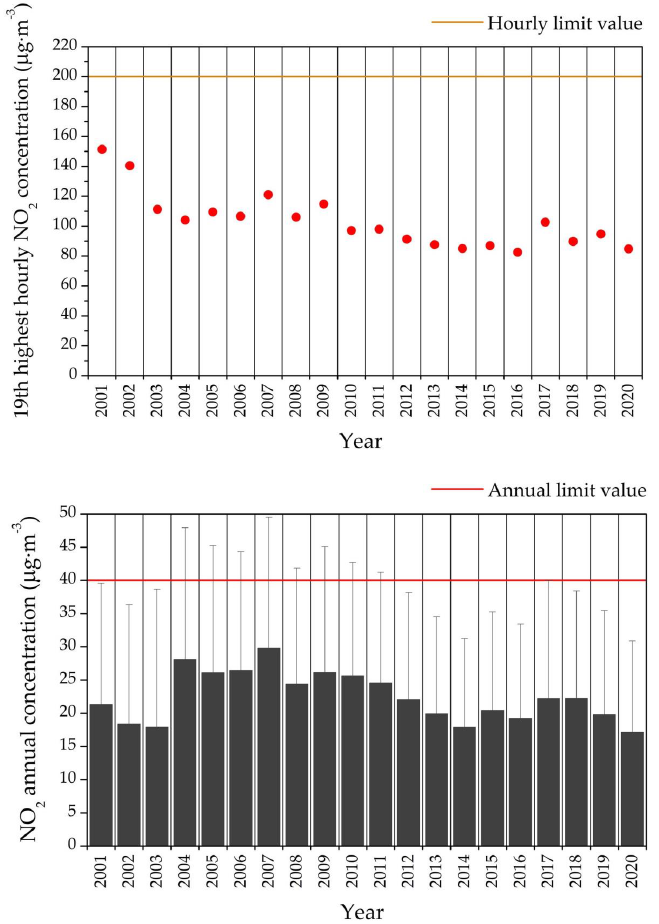
Figure 2. Levels of NO 2 in Seixal from 2001 to 2020: ( top ) 19th highest hourly means, ( bottom ) annual means (with standard